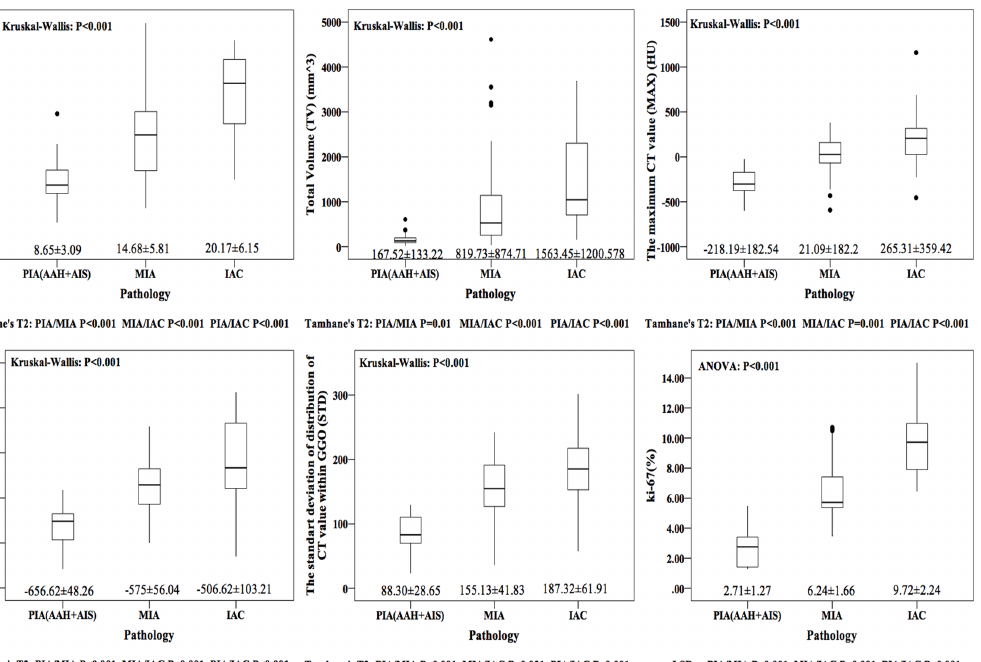
Fig 4. Graphs showing the mean diameter, total volume (TV), the maximum CT value (MAX), average CT value (AVG), standard deviation of CT value within the whole nodule (STD) and Ki-67 labeling index (LI) for preinvasive adenocarcinoma (PIA), minimally invasive adenocarcinoma (MIA) and invasive adenocarcinoma (IAC). Ki-67 LI was analyzed by ANOVA and LSD test due to homogeneity of variance and other variables were analyzed by Kurskal-Wallis test and Tamhane ’ s T2 for heterogeneity of variance. While all variables were significantly different among PIA, MIA and